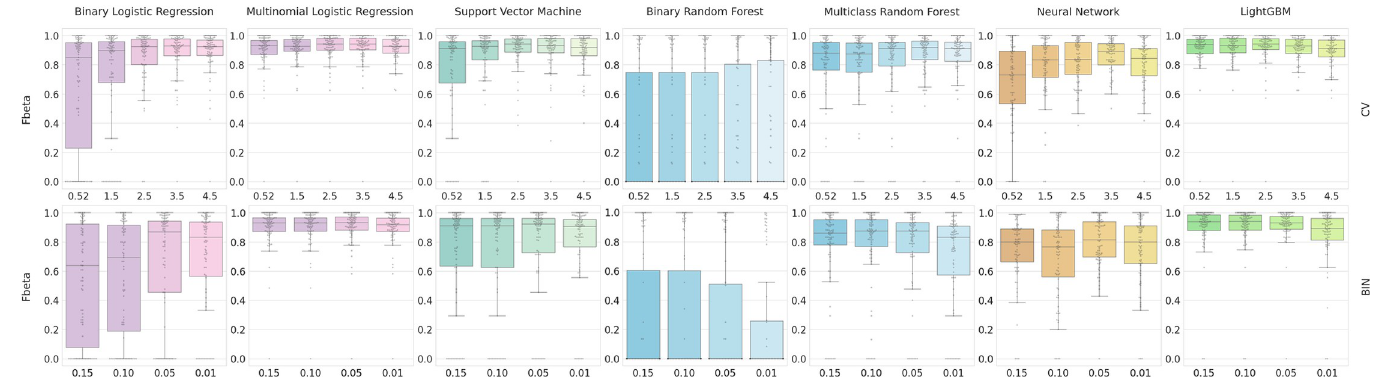
Fig 2. Classification performance using two feature selection methods (CV vs BIN filtering) and five machine learning methods. For feature selection using coefficient of variation (CV), the filtering thresholds from left to right were 0.52, 1.5, 2.5, 3.5, and 4.5. For binary score (BIN), the filtering thresholds from left to right are 0.15, 0.10, 0.05, and 0.01. The resulting number of genes for each threshold is listed below the threshold labels. Each of these feature sets was used by five different machine learning methods (LightGBM, Neural Network, SVM, Logistic Regression, Random Forest) using the training data. F-beta was calculated as a measure of classification